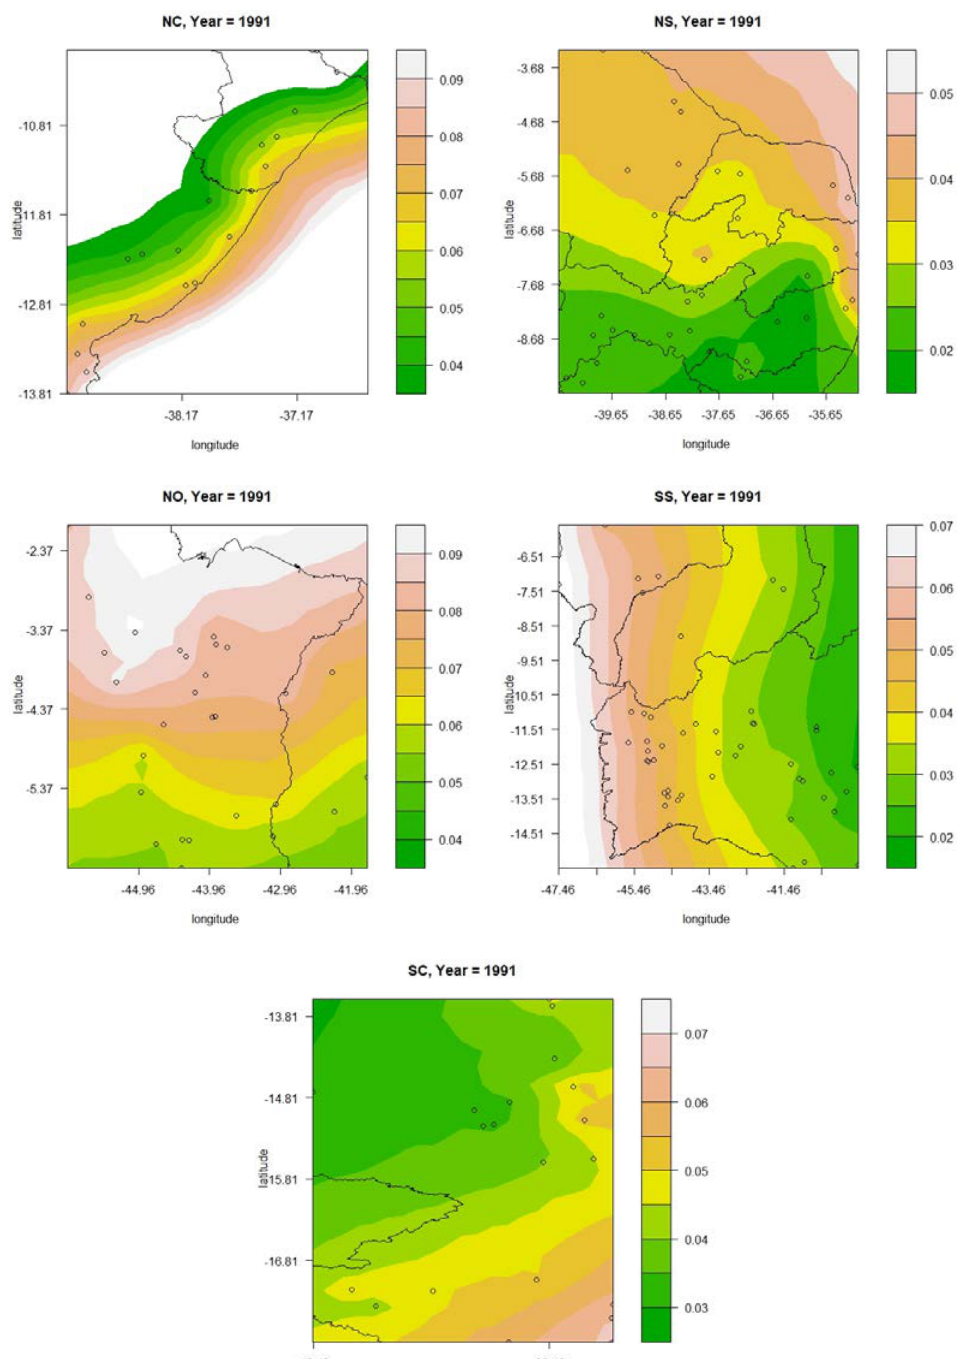
Figure 3. Predictions of rainfall relative frequency that exceeded the 20 mm threshold in the NC, NS, NO, SS and SC regions in 1991.